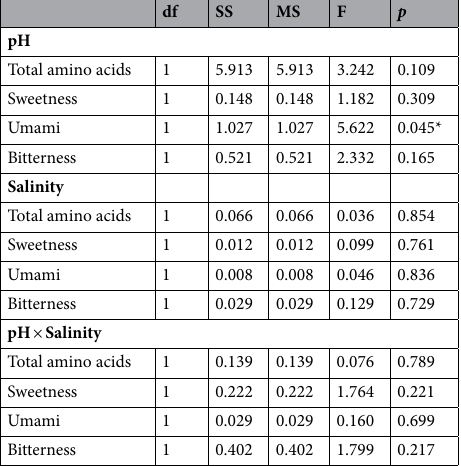
Table 2. Two-way ANOVA for the effects of salinity and pH on total amino acid expression and the different types of flavors they elicited. df = degree of freedom, SS = sum of squares, MS = mean squares, F = value of F statistic, p = p -value. Significant difference at p < 0.05 is indicated by asterisk.